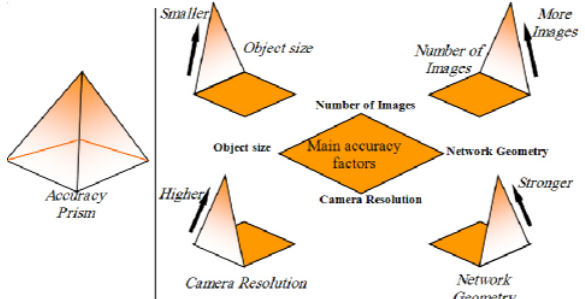
Figure2. Factors affecting accuracy of VMS systems.(GSI, 2000) Important and necessary role of the network design and its implementation process to achieve the ultimate accuracy of the calculations is shown in figure